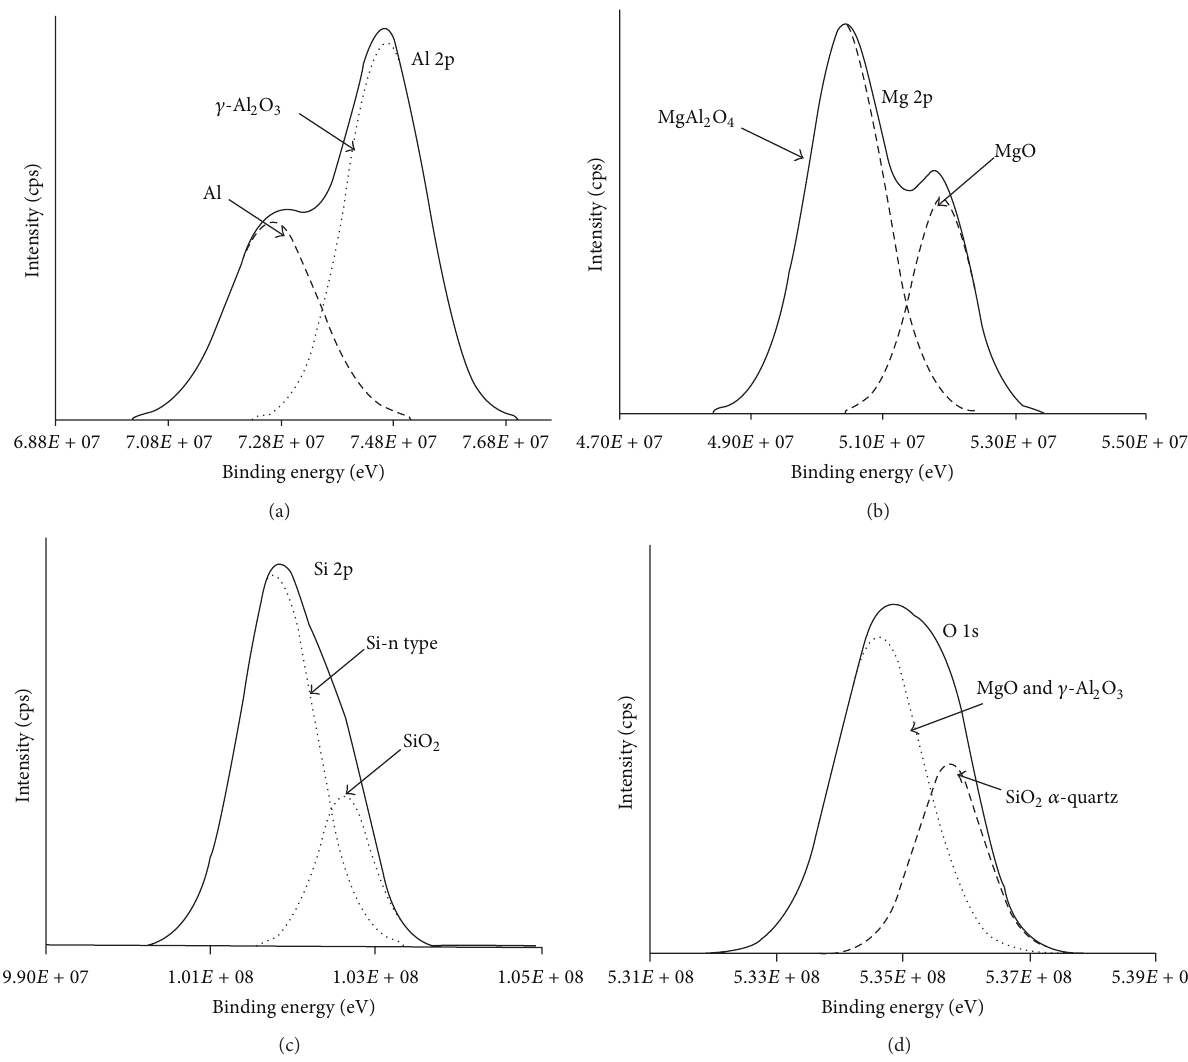
Figure 10: The detail profile of XPS scan (a) Al 2 p, (b) Mg 2p, (c) Si 2p, and (d) O 1s signals of oxidized fused metal part of AA6061 welded Al alloy at 600 ∘ C for 40 hours exposure